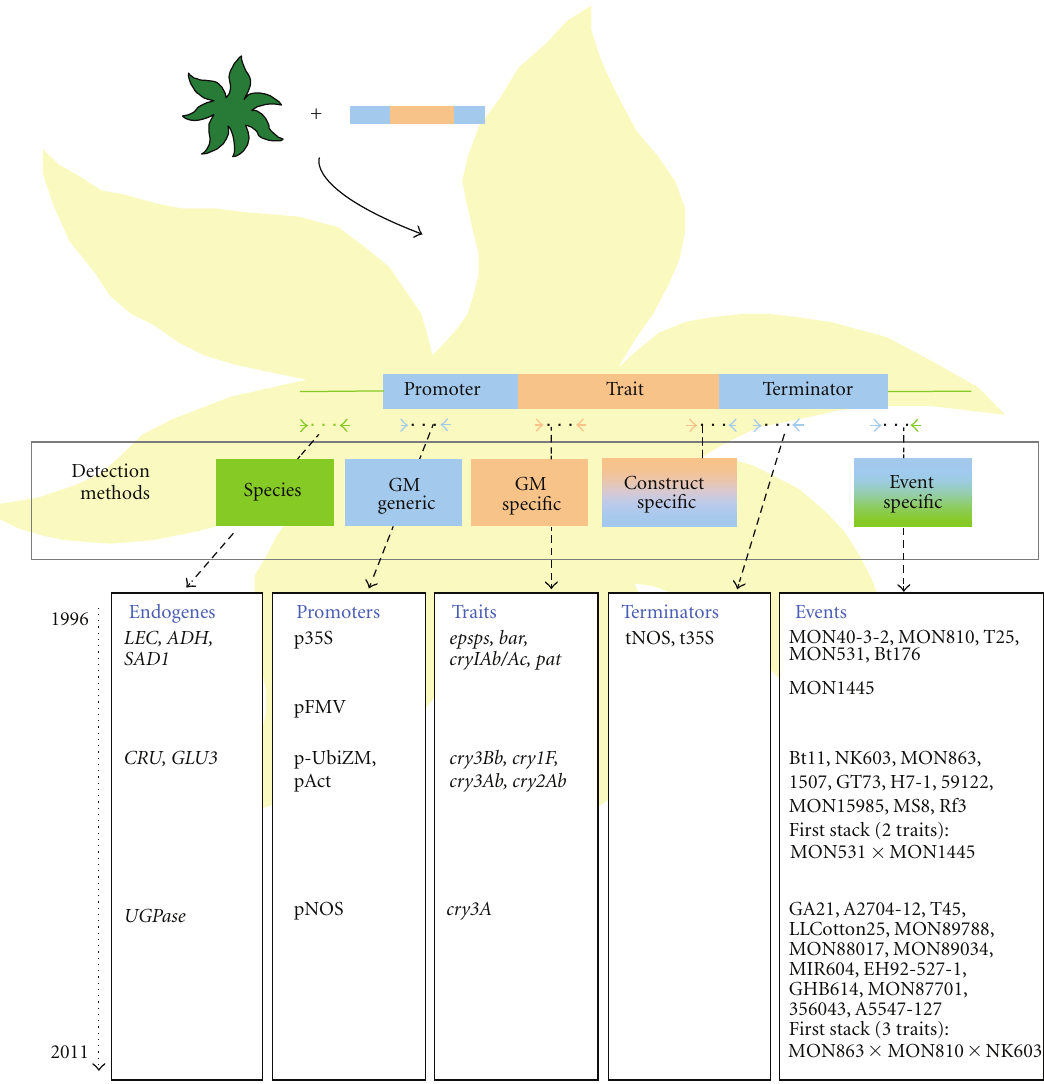
modified and brought onto the feed and food market.